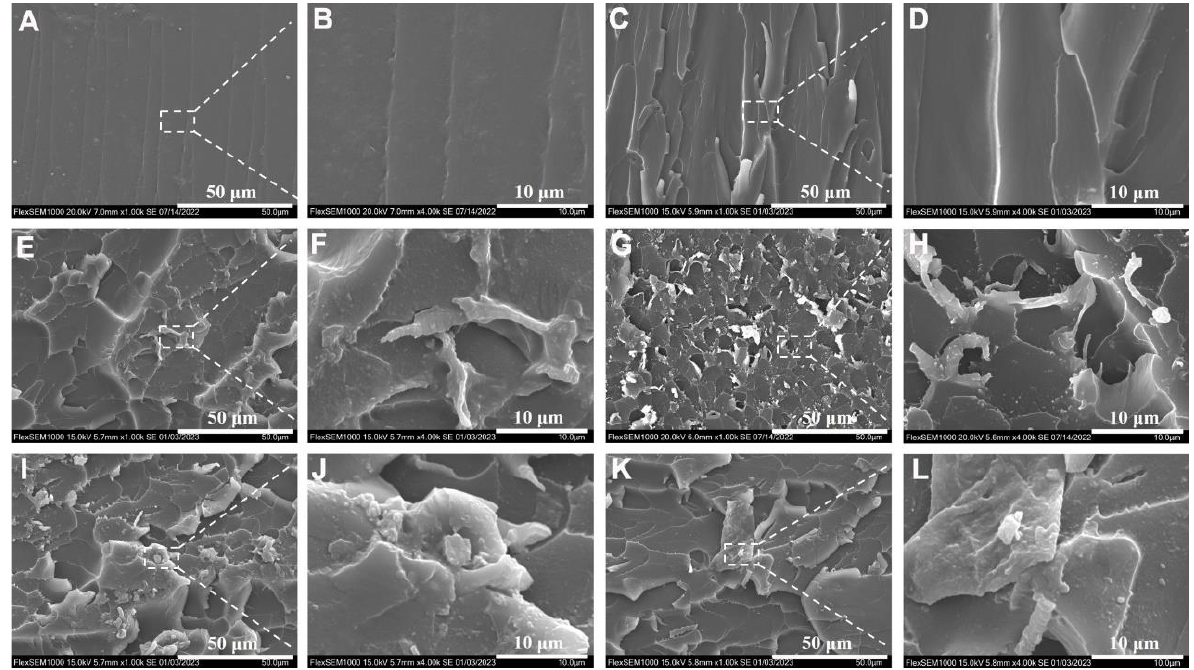
Figure 10. SEM micrographs of the low-temperature impact section of PPENK/E51 (( A , B ) E51, ( C , D ) 3 phr, ( E , F ) 5 phr, ( G , H ) 10 phr, ( I , J ) 15 phr, ( K , L ) 20 phr).